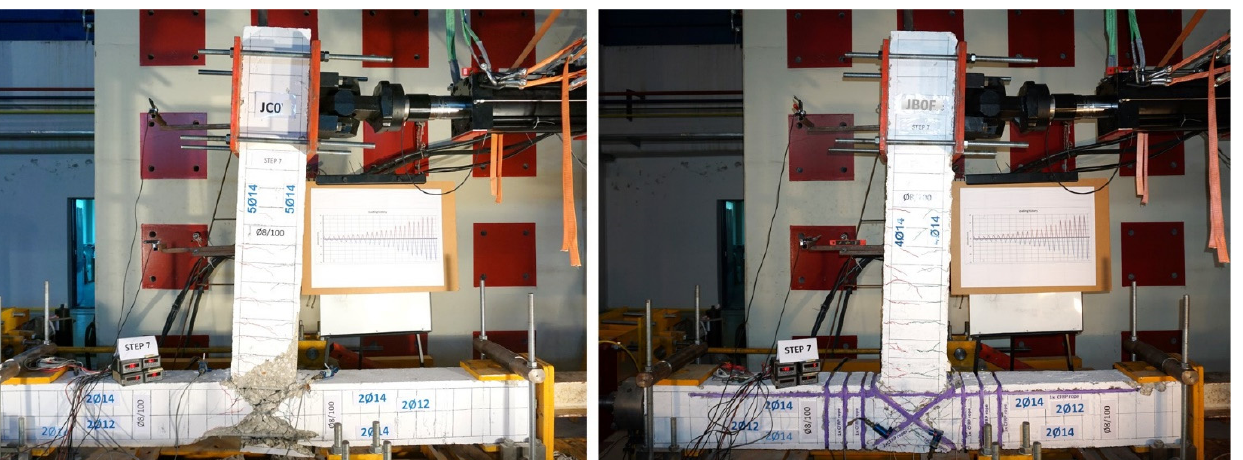
Figure 8. Comparative presentation of the dissipated energy of the two specimens in terms of the area of the hysteretic cycles. It was observed that the dissipated energy values of the strengthened specimen JB0F with the C-FRP ropes were, in all cycles, higher than the corresponding ones of specimen JC0 without C-FRP ropes.